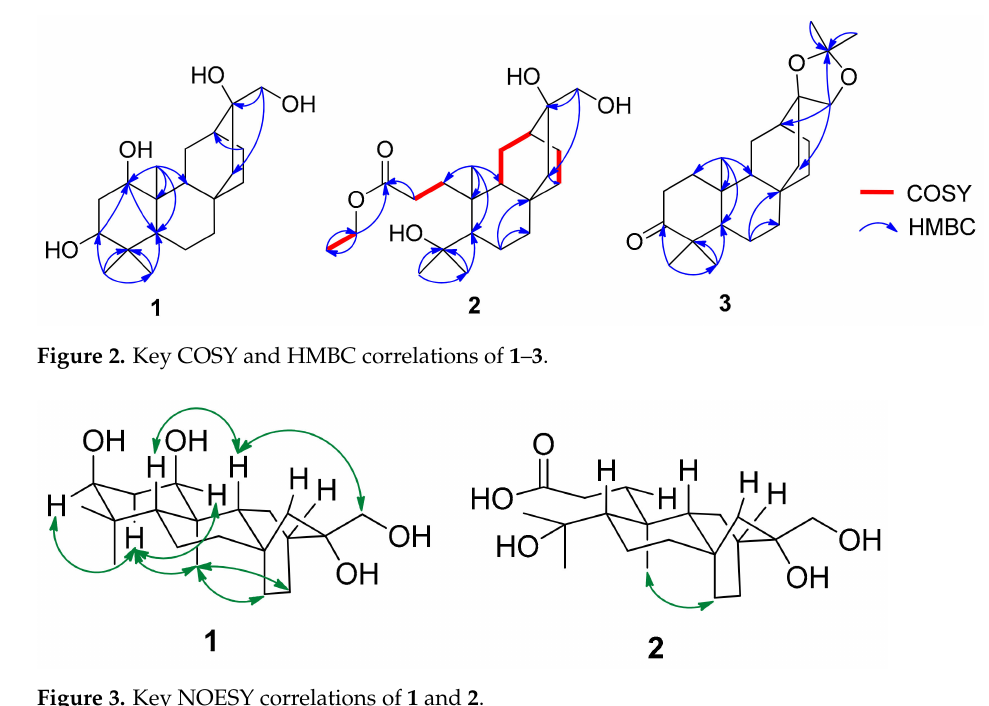
Figure 3. Key NOESY correlations of 1 and 2